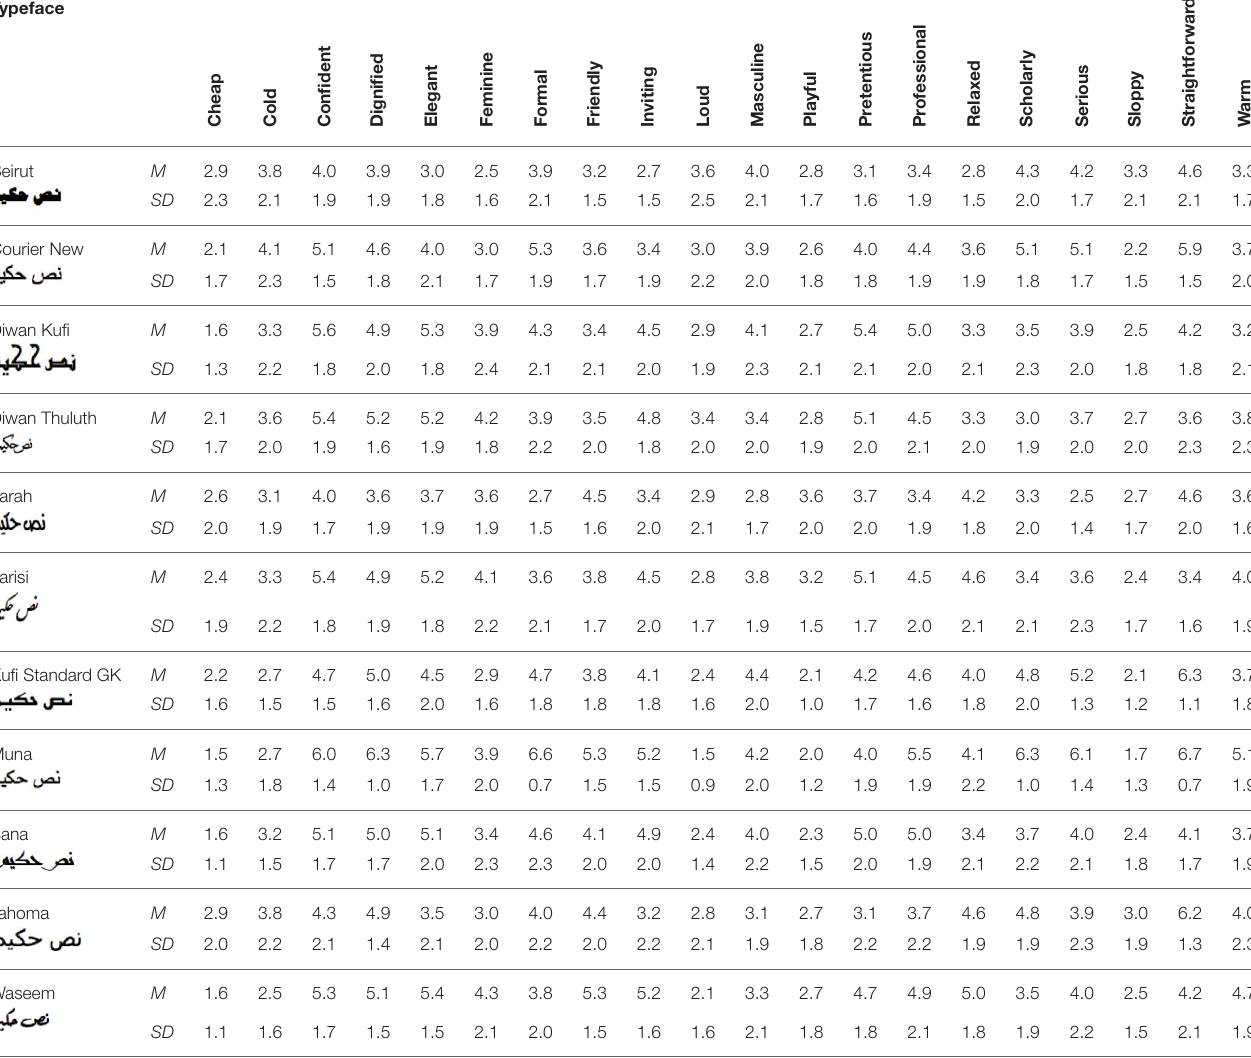
TABLE 3 | For each typeface, Mean Rating ( M ) and Standard Deviation ( SD ) are shown for each personality characteristic.